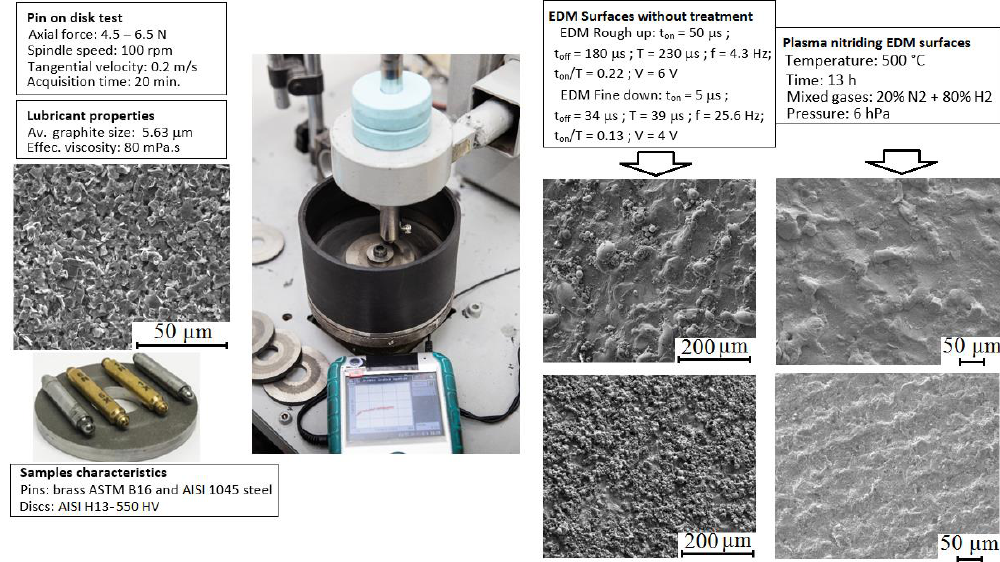
Figure 2. Pin-on-disk equipment used in this work and data for different experiments.